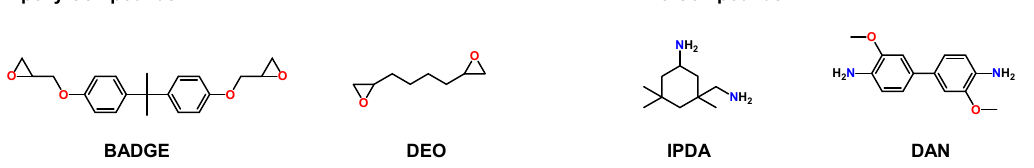
Figure 1. Chemical structures of the diepoxy compounds BADGE (bisphenol A diglycidyl ether) and DEO (1,2,7,8- diepoxyoctane) as well as the diamine compounds IPDA (isophorone diamine) and DAN ( o